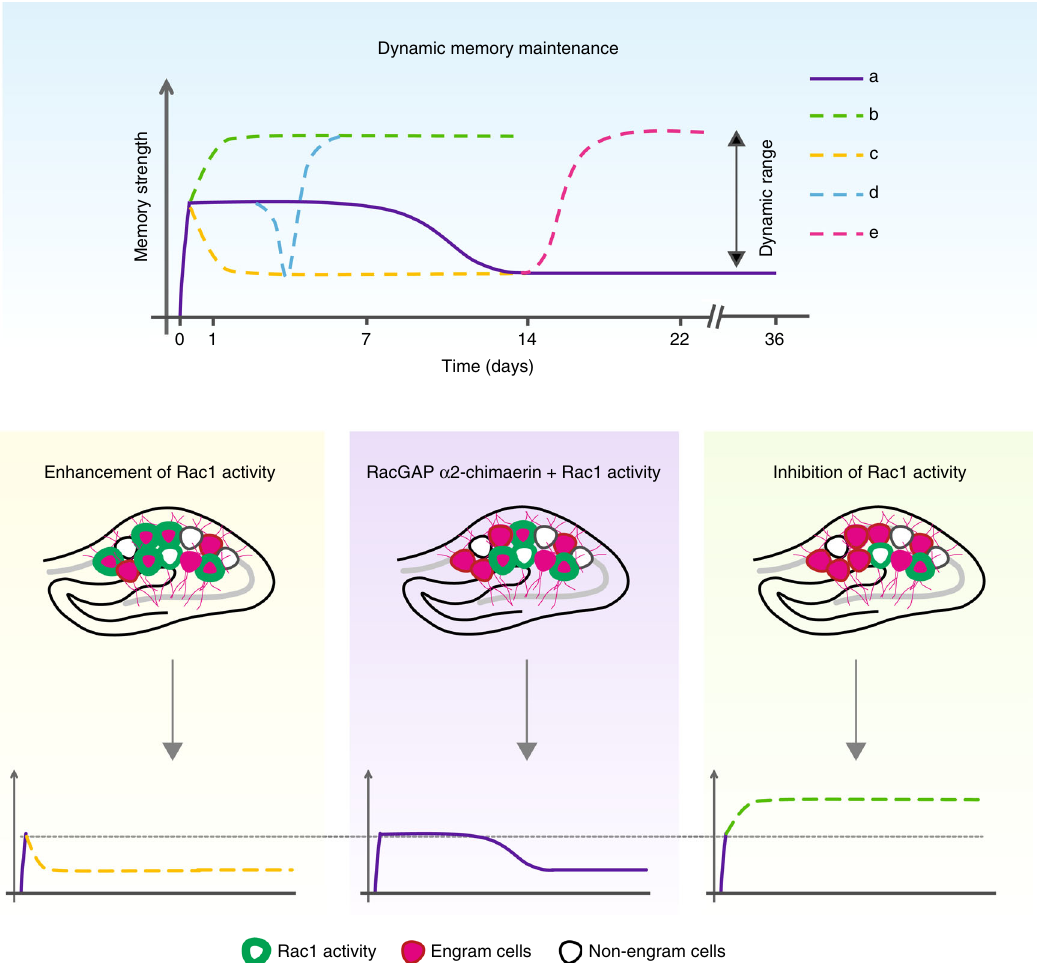
Fig. 7 Model of reversible forgetting-based dynamic memory maintenance. a Intermediate-level memory or normal memory. Memory is maintained at an intermediate level, which is de fi ned by interplay between learning-evoked activated Rac1 and learning-induced expression of α 2-chimaerin. b The top level of dynamic range. Inhibition of Rac1-dependent forgetting enhances consolidated memory through α 2-chimaerin overexpression, AAV-mediated expression of dominant-negative Rac1 (Rac1-DN), or injection of a Rac1 inhibitor Ehop016. c The bottom level of dynamic range. Stimulation of